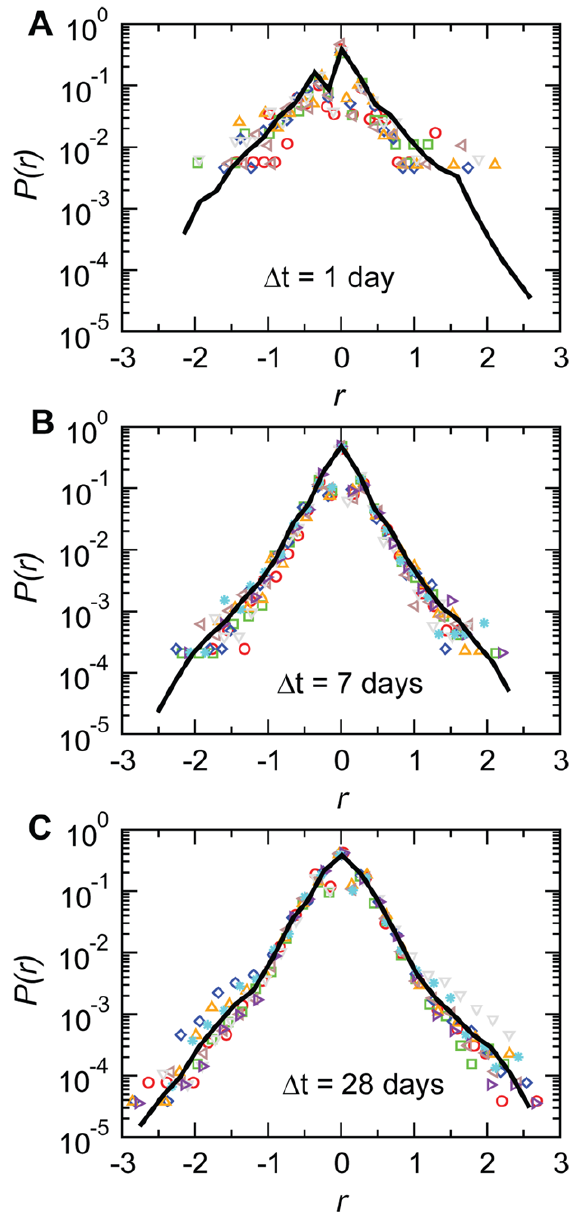
Figure 8. Distributions of the growth rates of the number of bovines w A displaced along a connection. The solid line represents the distribution of the growth rates considering all networks of a given aggregating time window D t . Symbols corresponds a selection of snapshots.